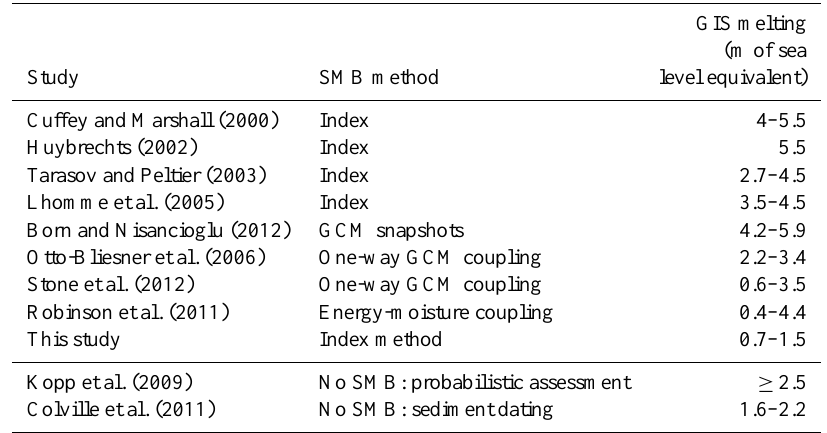
Table 1. Estimates of the GIS melting contribution to global sea level rise during the LIG period in previous ice sheet modelling studies. Two other estimates are also